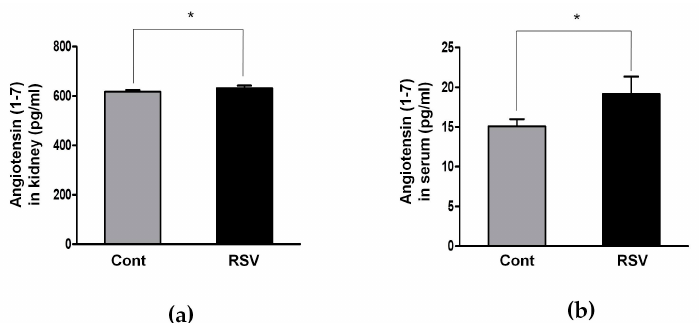
Figure 7. ELISA for serum and kidney levels of Ang 1-7. ( a ) Renal levels of Ang 1-7 significantly increased in the RSV group, compared to Cont. groups. ( b ) Serum levels of Ang 1-7 significantly increased in the RSV group, compared to Cont. groups. Quantitative analysis of the results is shown (* p < 0.05).